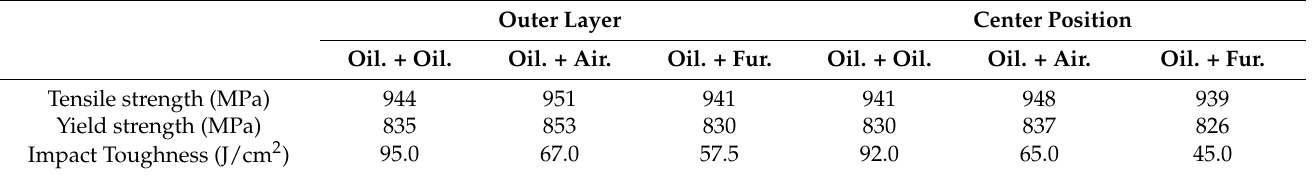
Table 6. Effect of tempering cooling rate on mechanical properties at 650 ◦ C during quenching and tempering. Outer Layer Center Position Oil. + Oil. Oil. +